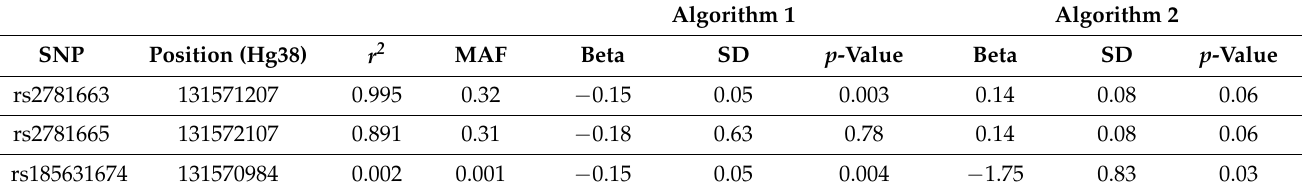
Table 1. Algorithm 1 considers the association of rs2781659 with bronchodilator response (BDR) conditioning on the SNPs in column 1 and Algorithm 2 considers the interaction of rs2781659 with the SNPs in column 1 on BDR. MAF denotes the minor allele frequency and SD denotes the standard deviation in the table